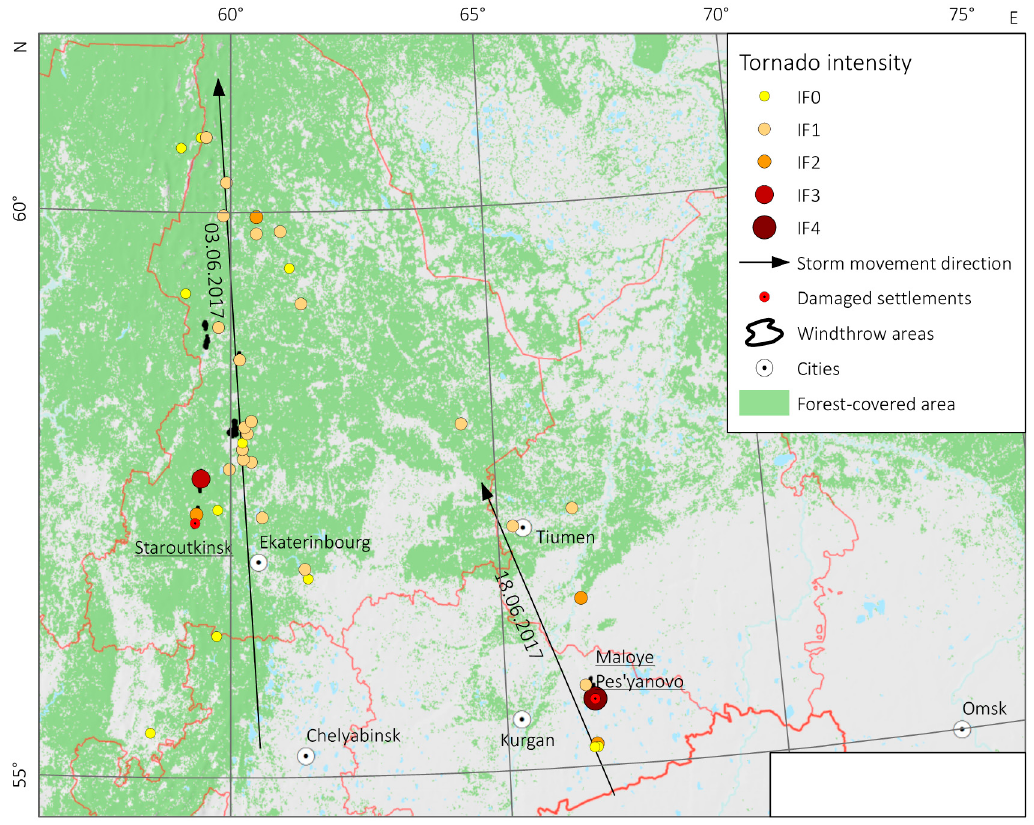
Figure 6. Tornadoes and large-scale ( > 1 km 2 ) windthrow events reported at 3 June 2017 and 18 June 2017 (the most probable intensity rating is shown).